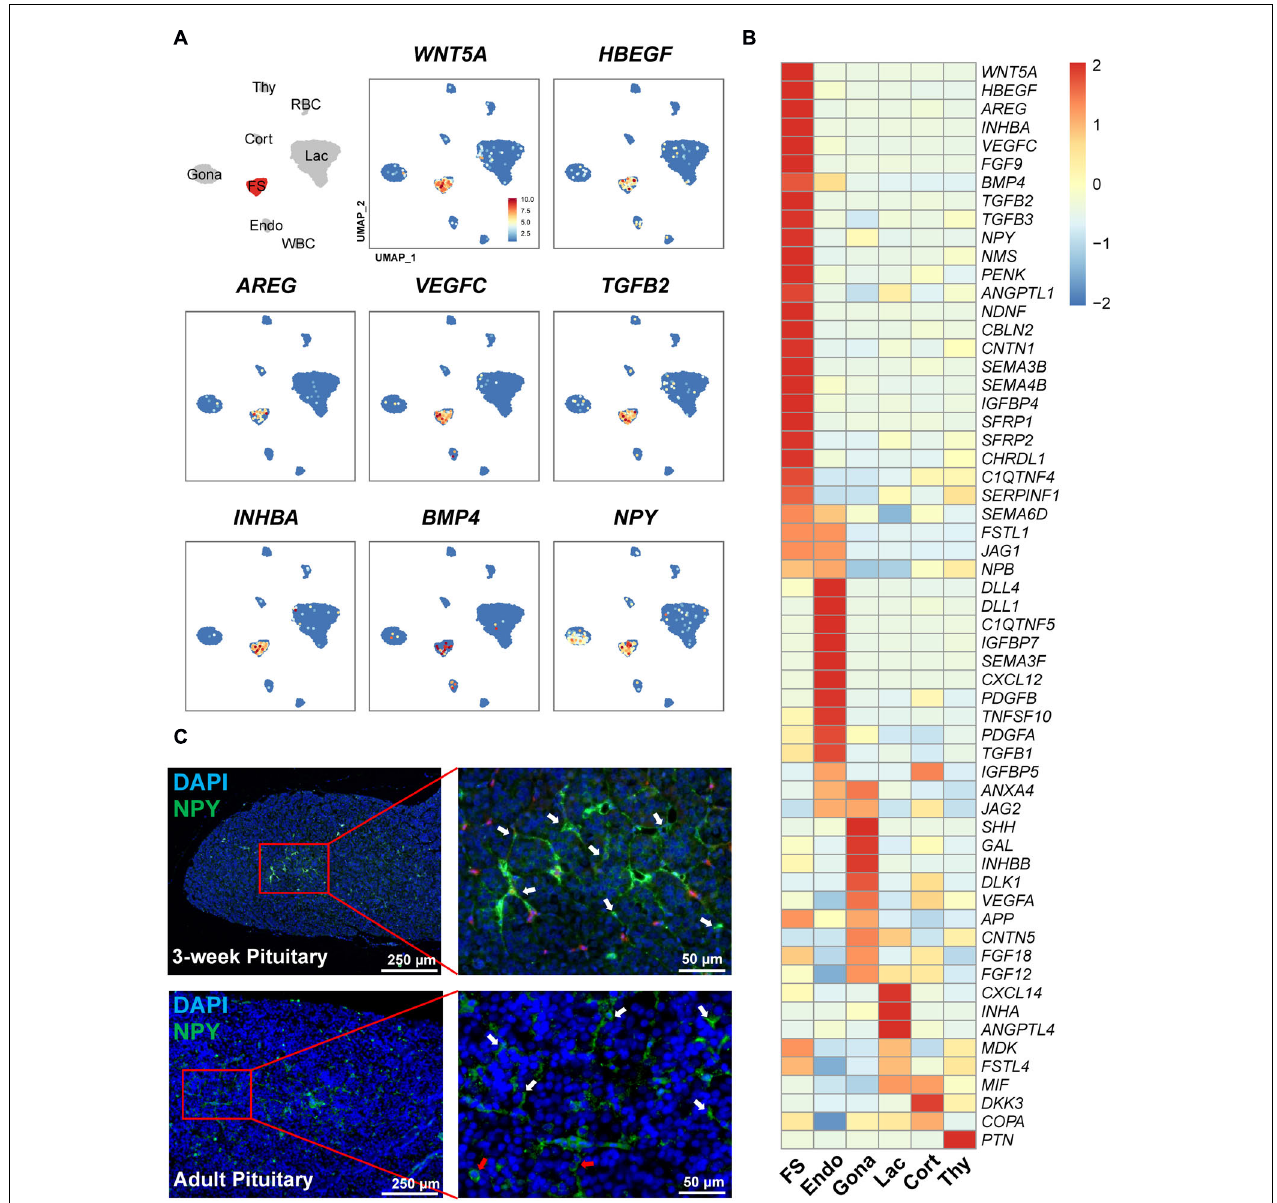
FIGURE 8 | Expression of the genes encoding growth factors and peptides in FS-cells and other cell clusters. (A) UMAP maps showing the abundant/specific expression of some genes encoding growth factors and peptides ( WNT5A , HBEGF , AREG , VEGFC , TGF β 2 , activin A (encoded by INHBA ), BMP4 , and NPY ). Dark red and light blue indicate high and low expression levels, respectively. (B) Heat-map showing the mRNA levels of the genes encoding growth factors and peptides in FS-cells and other cell types. The expression level of each gene was normalized to the z -score and color-coded. (C) Validation of neuropeptide Y (NPY) expression in FS-cells (marked by white arrows) and endocrine cells (red arrows) of 3-week chick and adult chicken anterior pituitaries by immunofluorescent staining. The NPY immuno-reactive signal was labeled with Alexa Fluor 488 (green). Nuclei are stained with DAPI (blue). Scale bar: 250 µ m/50 µ